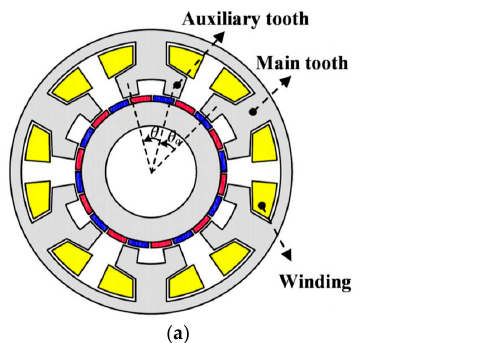
Figure 4. Configuration of a surface Vernier PM (SVPM) machine [18].